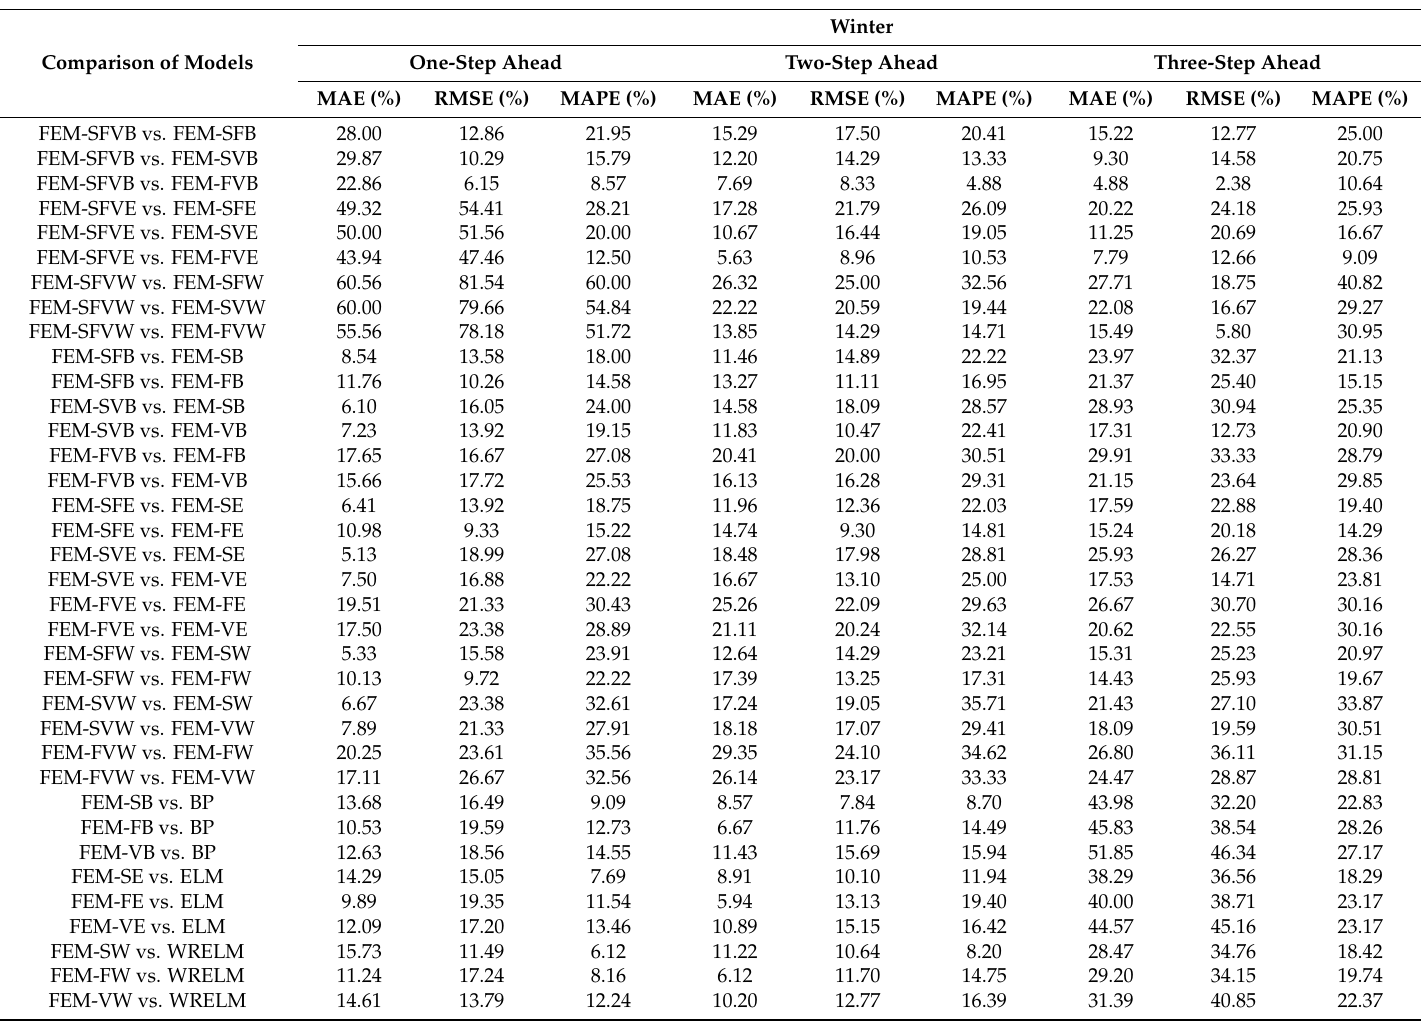
Table 14. Comparison results of experiments III, IV and V in